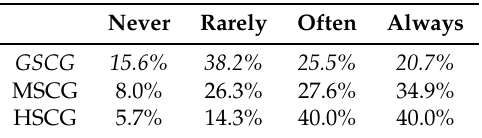
Table 7. How frequently do you check the permissions (access rights) that the application requires before completing the installation?